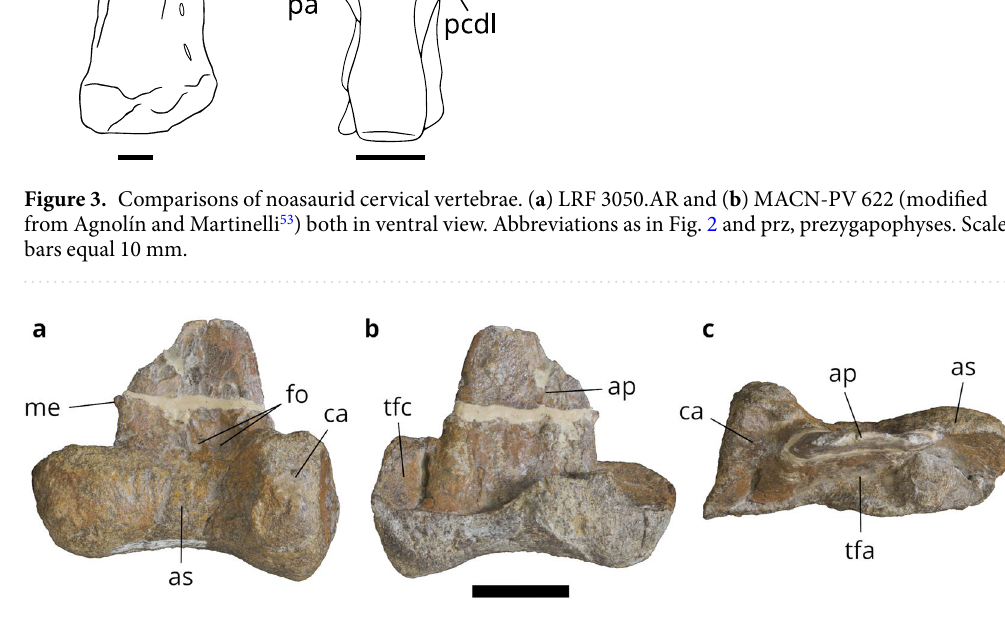
Figure 4. The astragalocalcaneum NMV P221202 in ( a ) anterior, ( b ) posterior, and ( c ) proximal views. Abbreviations: ap, ascending process of the astragalus; as, astragalar body; ca, calcaneum; fo, lateral anterior fossae; me, medial eminence; tfa, tibial facet of the astragalus; tfc, tibial facet of the calcaneum. Scale bar equals 20